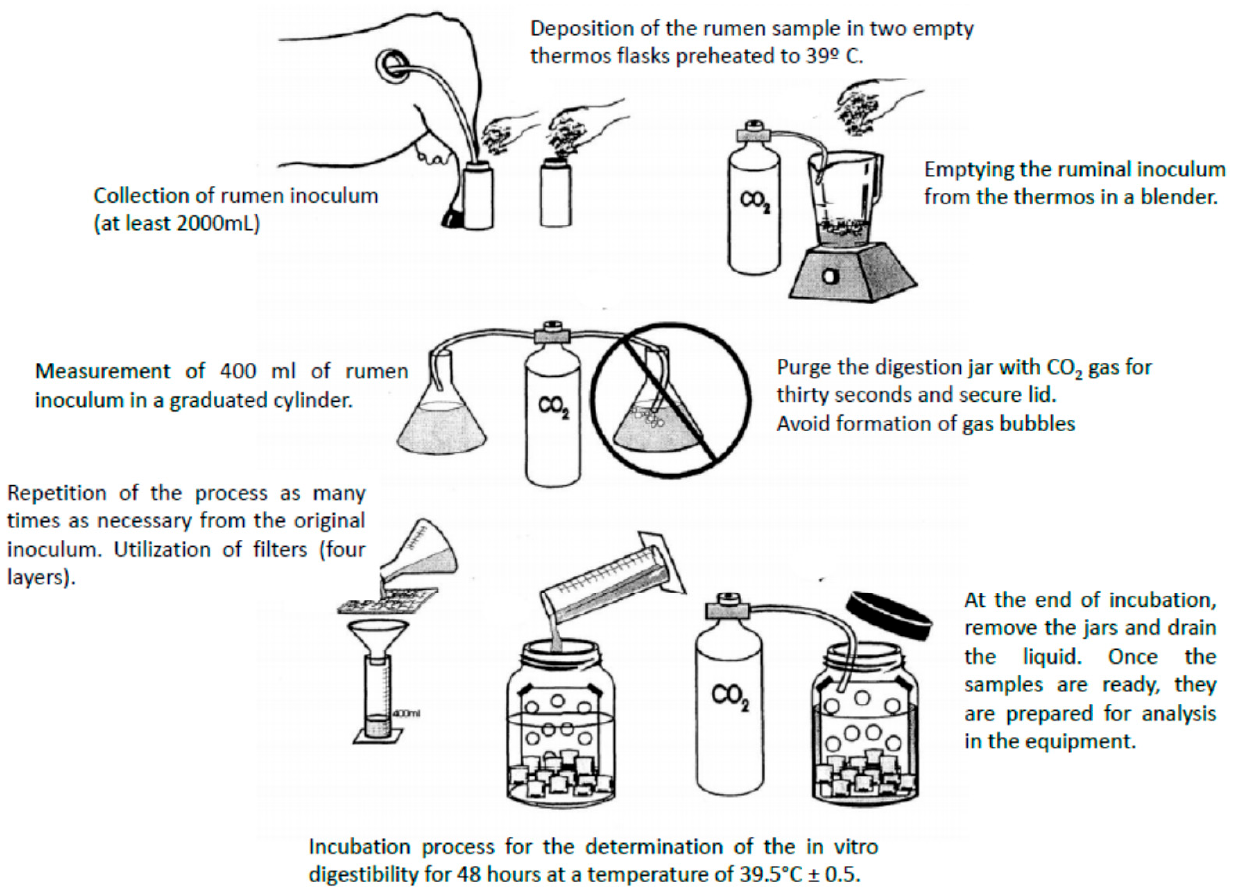
Figure 5. Schematic procedure for collection and preparation of rumen samples to be analyzed by the fermenter DaisyII Incubator (adapted from https://www.ankom.com/sites/default/files/document-files/Method_4_InVitro_Procedure_ Illustrations_D200_D200I.pdf, accessed on 26 April